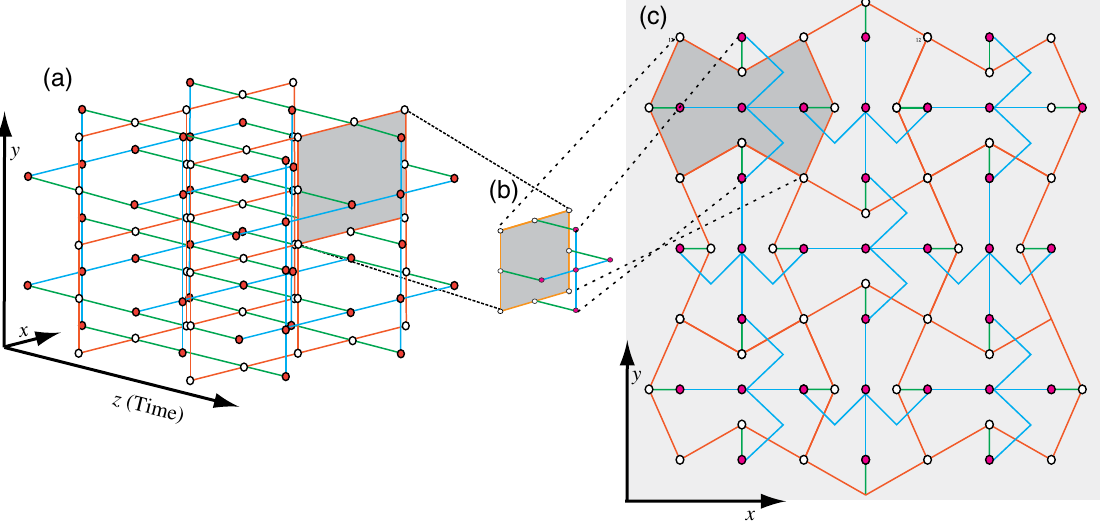
FIG. 5. Three-dimensional topological cluster state and module connectivity in a two-dimensional plane. (a) The topological cluster state cluster is a resource for fault-tolerant quantum computation. However, the whole state is not required at all times during the computation. Instead, only two layers of the cluster state need to be prepared and stored at any given time. (b) The physical unit cell composed of two layers. The back layer contains eight connected qubits arranged in a square (orange), while the front layer has five qubits arranged in a cross (blue). The two layers are connected by controlled-phase gates (green). Measurement of the front layer of the cluster will teleport the current state of the computer to the back layer, at which point the physical qubits we just measured can be reconnected in accordance with the geometry of the cluster state, and the information can be teleported back again. In this way, the two physical layers execute the even and odd temporal steps of the computation, allowing an arbitrarily deep computation to be performed with a fixed number of physical qubits. (c) A compact layout of modules on a two-dimensional